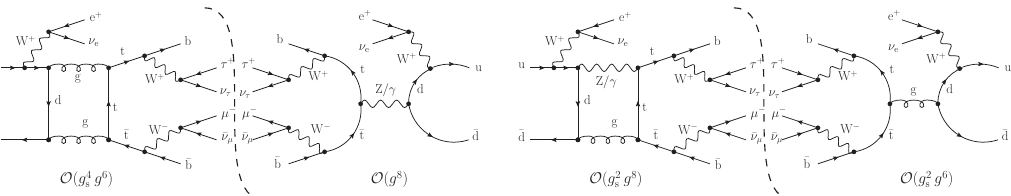
( α 2 α 7 ) virtual corrections to off-shell ttW production in the three- Figure 3: Sample s O charged-lepton decay channel: QCD corrections to the LO interference (left) and mixed contribution (right).